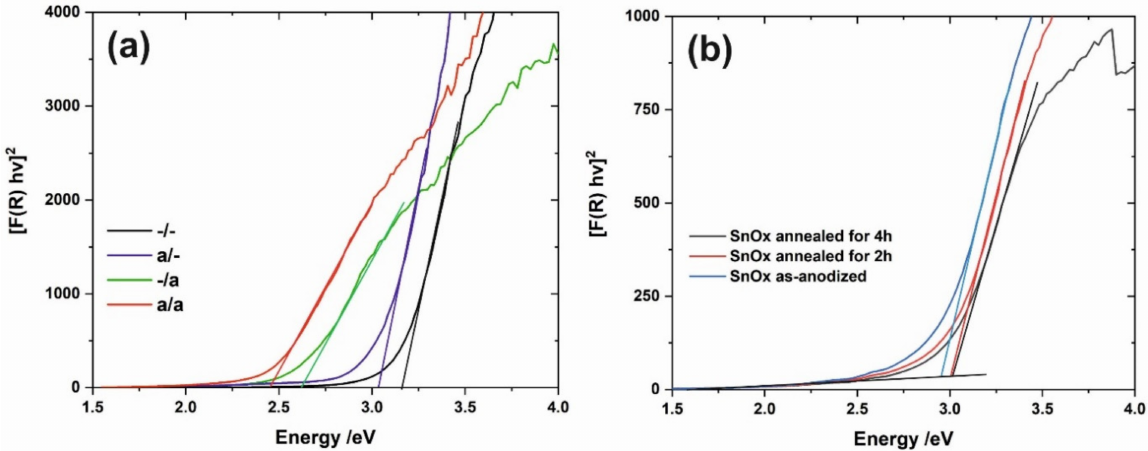
Figure 4. [F(R) hv] 2 vs. hv plots for all studied nanoporous SnO x /CdS ( a ) and unmodified porous SnO x ( b ).